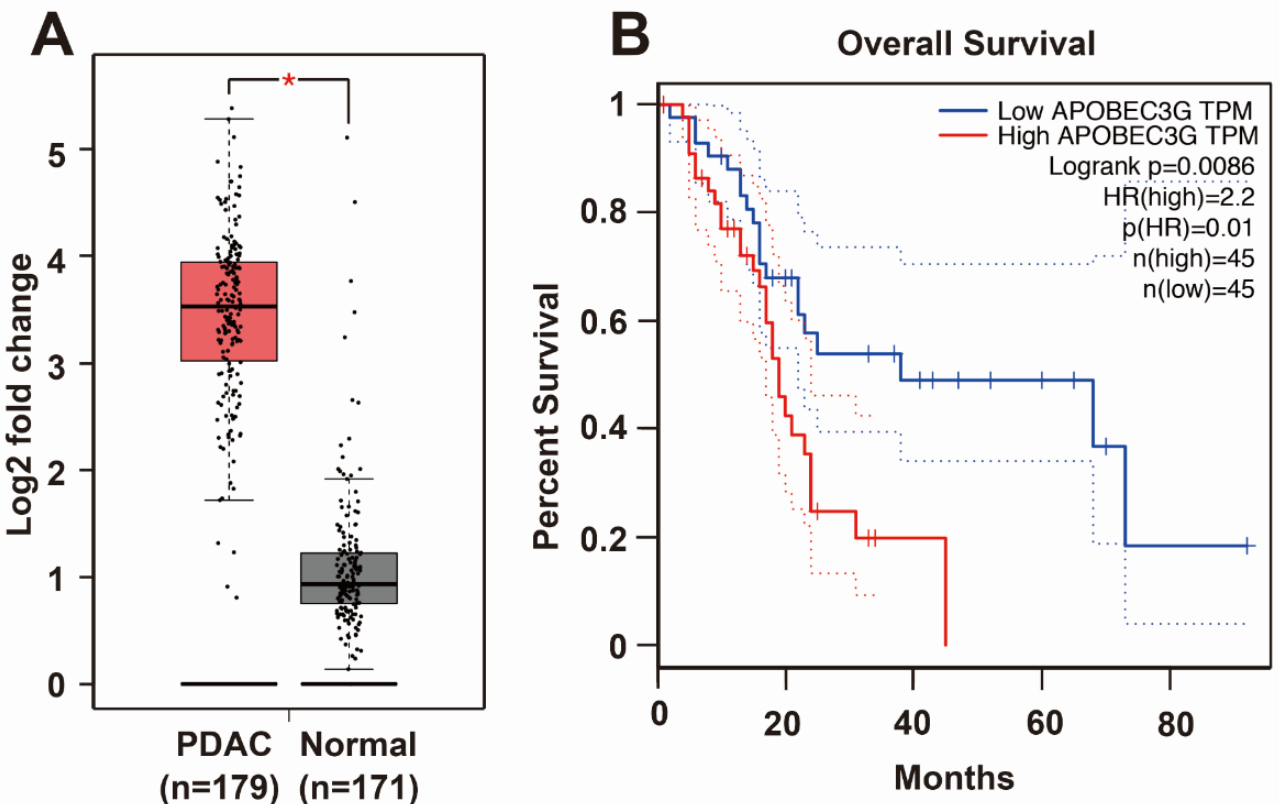
Figure 4. APOBEC3G is highly expressed in PDAC and related to overall survival. ( A ) TCGA and GTEx databases were utilized to evaluate the expression of APOBEC3G in human PDAC ( n = 179) and normal pancreas ( n = 171) tissues. ( B ) Overall survival data from patients with PDAC, with low or high APOBEC3G expression, were obtained from GEPIA, which is an online database providing patient survival analysis.